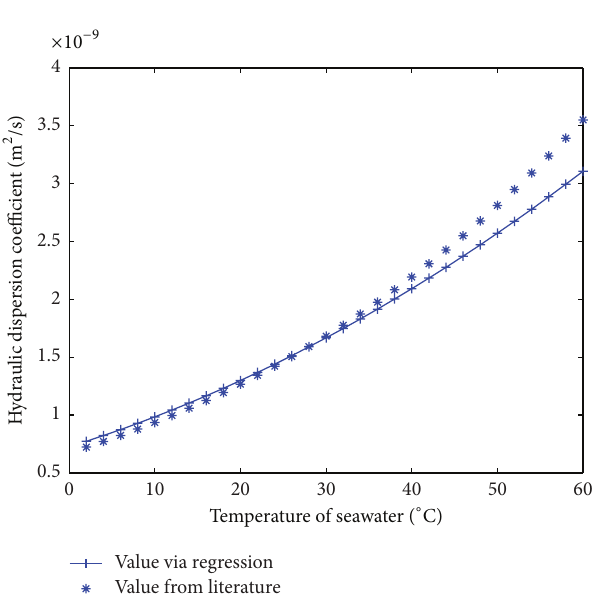
Figure 5: Comparison of DAB with literature.